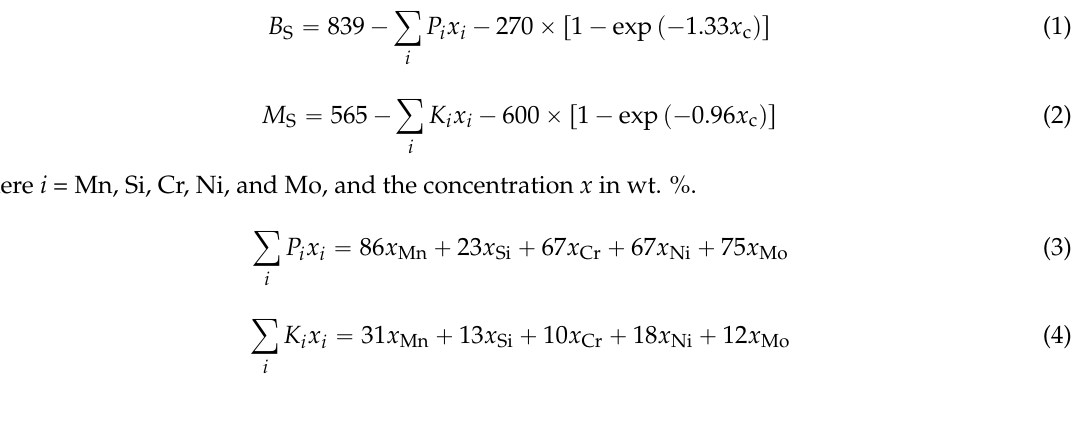
Table 1. Chemical compositions of steels (wt.